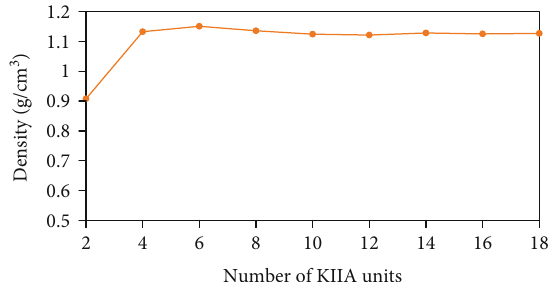
Figure 7: Density convergence of kerogen structures built using an increasing number of kerogen units.